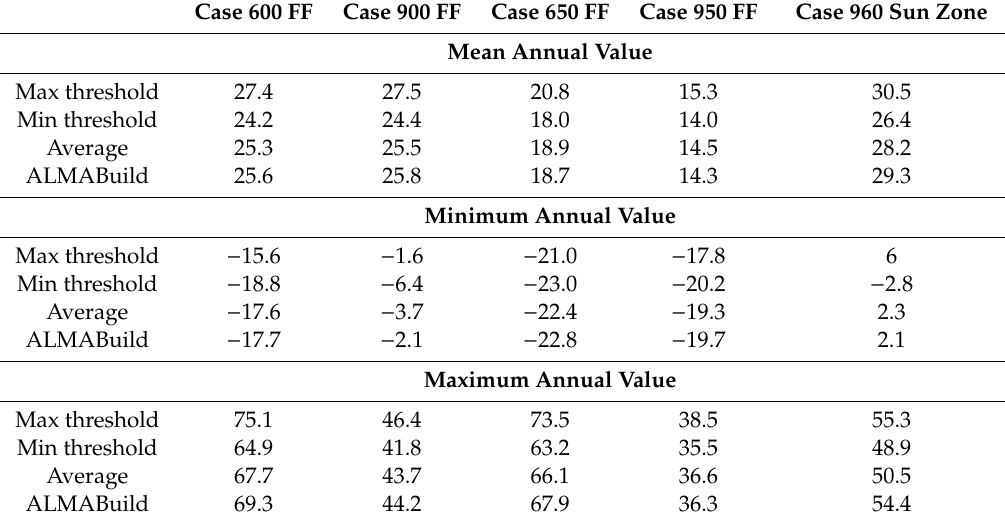
Table 2. Annual internal air temperature values ( ◦ C) obtained for free-float (FF) BESTEST cases compared with the minimum and maximum threshold values indicated by